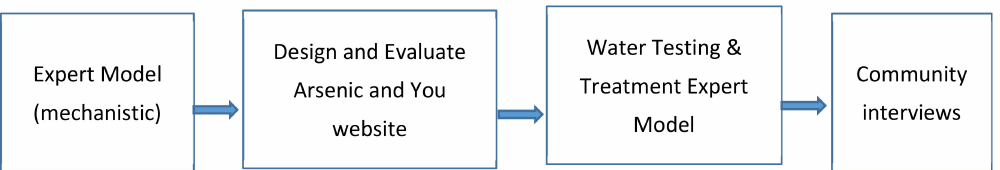
Figure 1. Steps in the iterative process of arsenic (As) risk communication research.